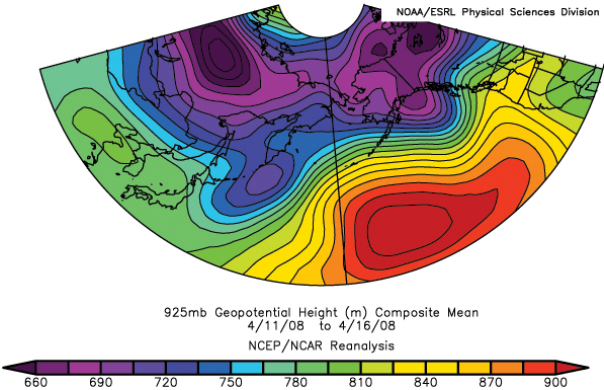
Fig. 9. Mean 925hPa geopotential height (m) pattern, 11–16 April. The large high pressure zone south of the Aleutians pushes the Asian exit flow northwards such that it is in a position to move into the AK Interior between the mountain ranges. This represents the most favorable pathway to transfer unmodified airmasses into the Interior. This period captures the general trajectory leading to the balloonsonde launch of 19